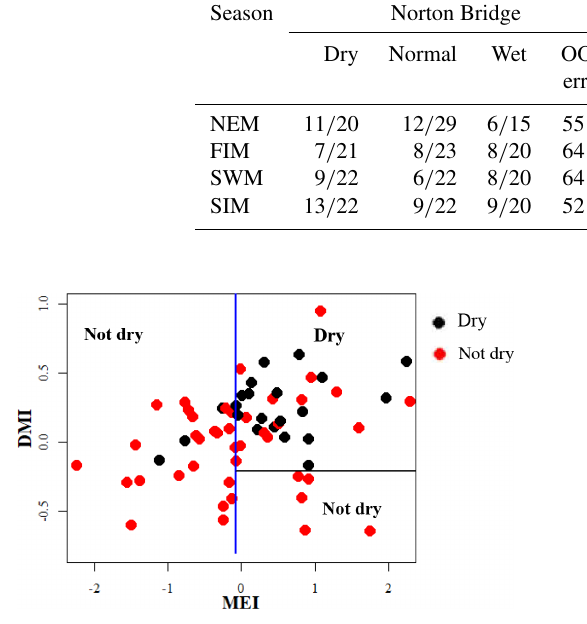
Figure 5. Classification tree for Norton Bridge SWM rainfall using two categories (dry and not dry).